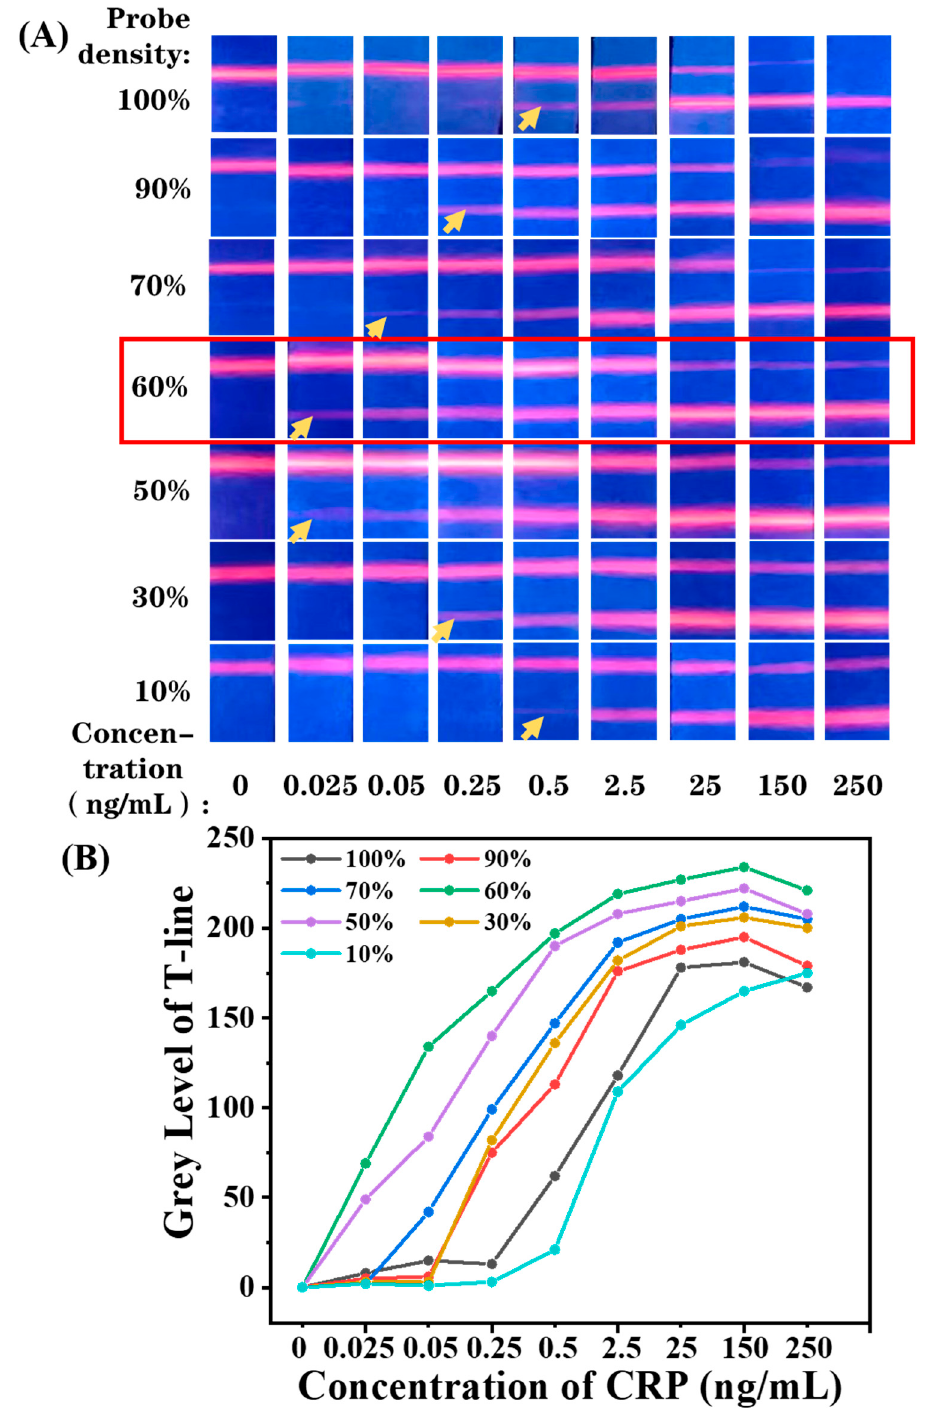
Figure 4. ( A ) Schematic illustration of antibody density affecting fluorescence signal at T-line and C-line. ( B ) The relationship curve of fluorescence intensity and CRP concentration with the different antibody density.